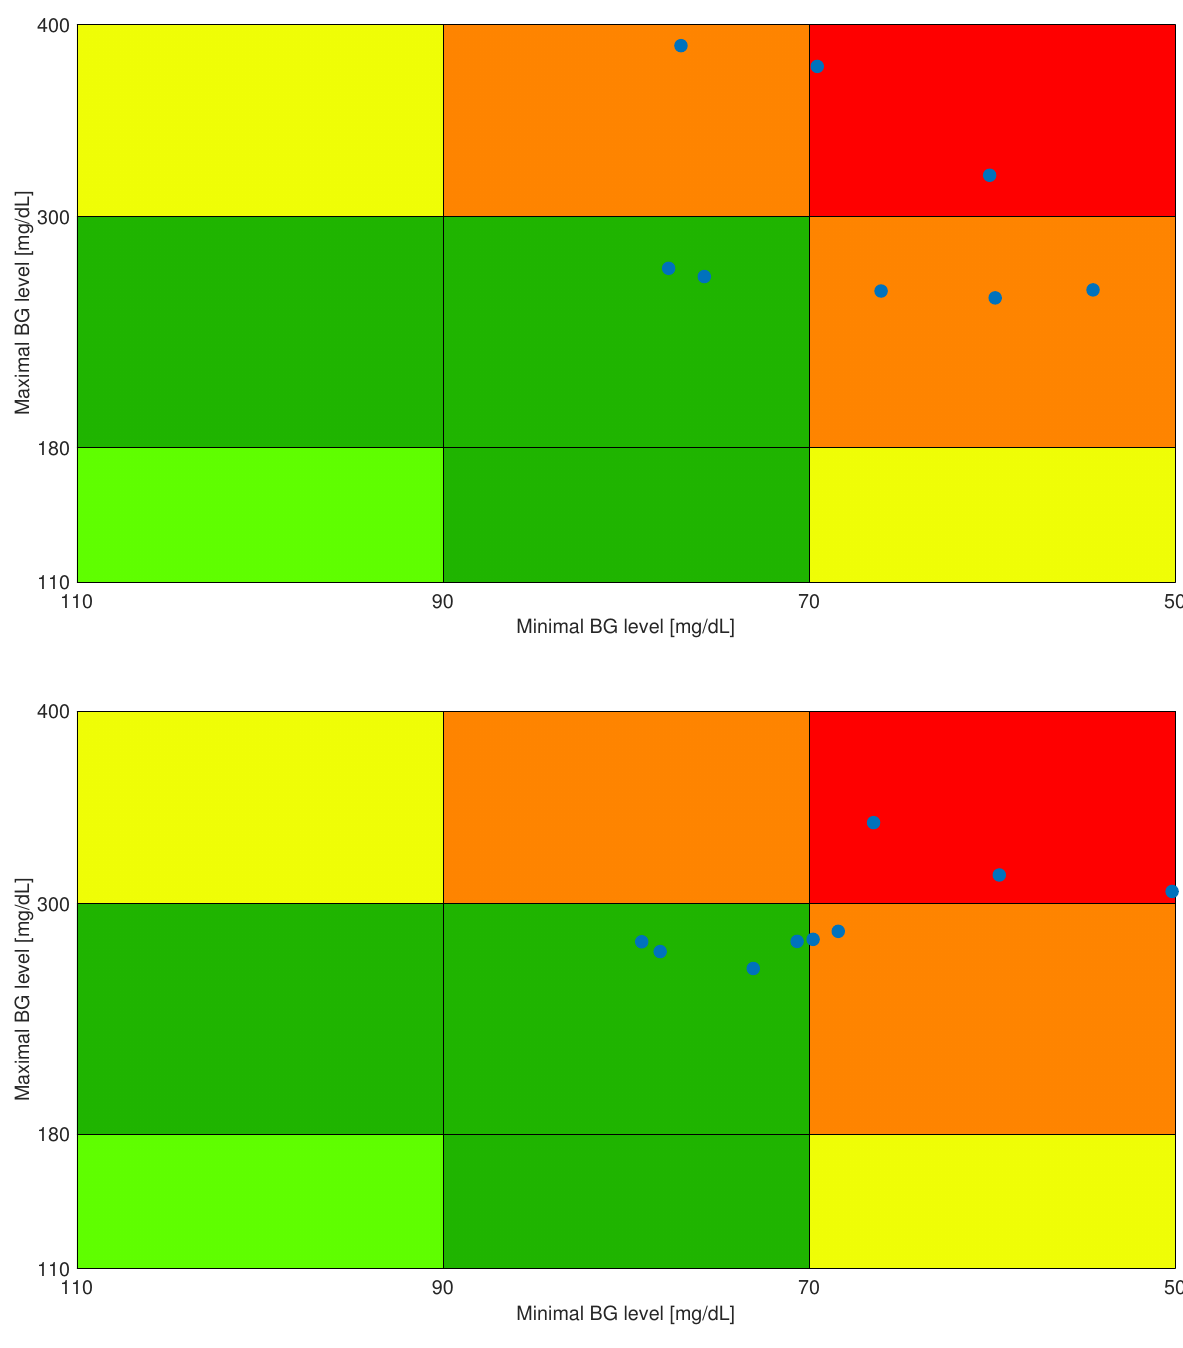
Figure 7. CVGA plot of the BG levels attained during the simulation. The top figure shows the slow adaptation case, while the bottom corresponds to the fast. The green zones (A,B) indicate safe levels, yellow zones (C) are the acceptable levels, orange zones (D) are the on the margin of safety, and the red zone (E) indicates life-threatening